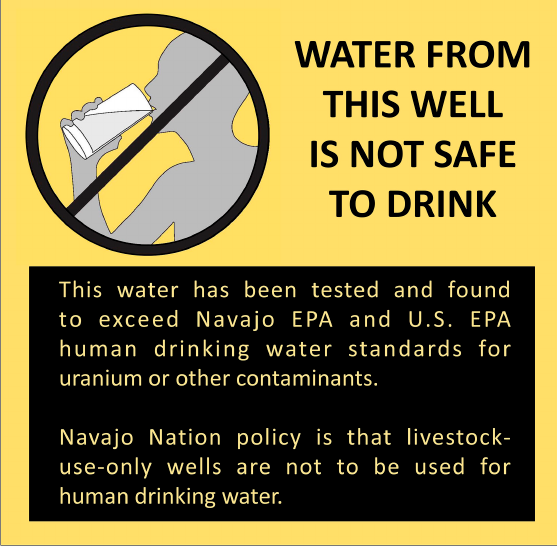
Figure 2. Sign erected by the Navajo and U.S. EPA which is typical for many of the water sources on the reservation. Figure from EPA Pacific Southwest Region 9 Addressing Uranium Contamination on the Navajo Nation